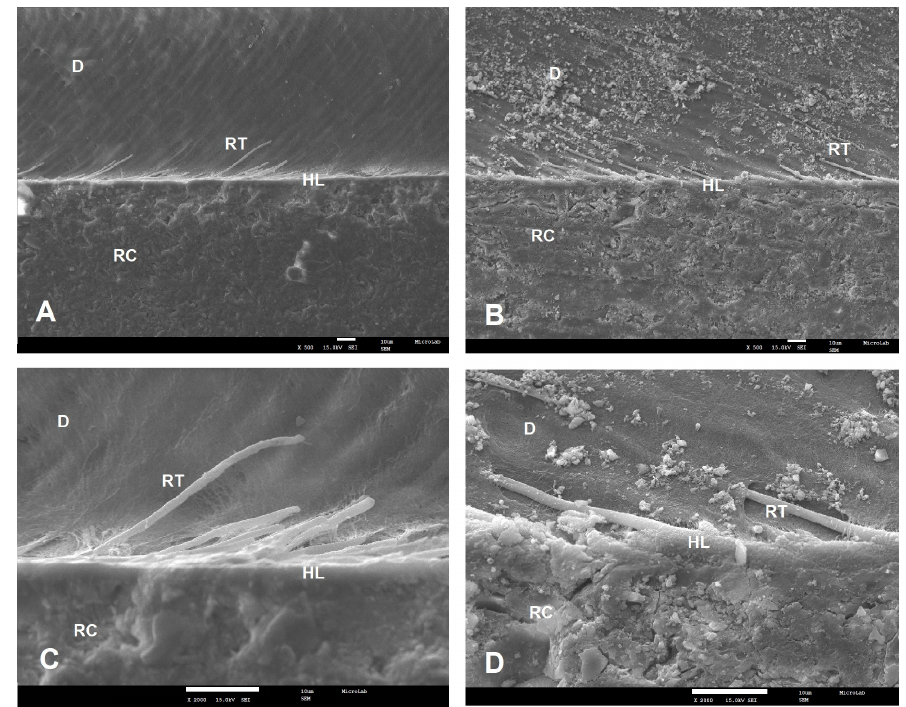
Figure 3. SEM micrographs of the bonding interface of the commercial adhesives when SE was applied. Magnifications of 500 × ( A , B ) and 2000 × ( C , D ) were used. A and C —SBU; B and D —FUT. RC—resin composite; D—dentin; HL—hybrid layer; RT—resin tags.